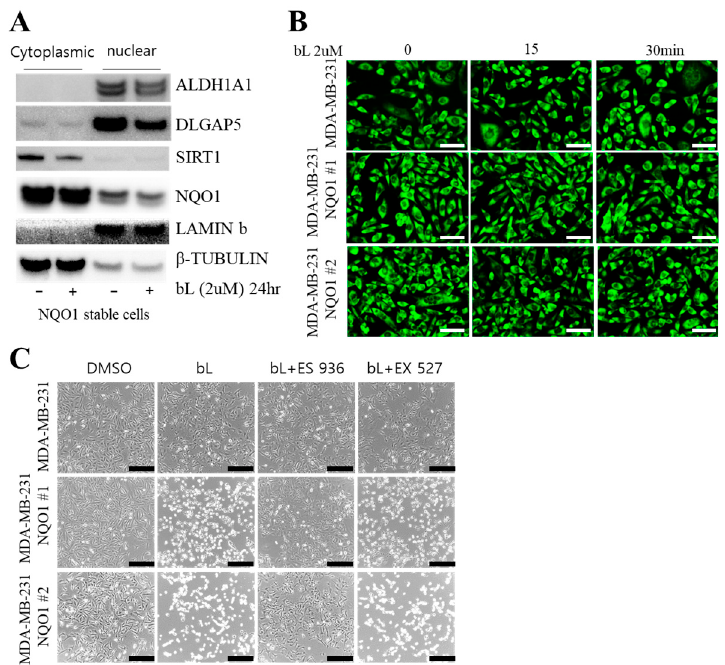
Figure 3. Sirtuin 1 (SIRT1) is not involved in bL-NQO1-mediated cell death. ( A ) Cytoplasmic and nuclear fractionation was performed as described in Section 4, using NQO1 stable cells with or without bL (2 µ M) for 24 h. The cell lysate was subjected to Western blot analysis with the indicated antibodies; β -tubulin and lamin B were used for cytoplasmic and nuclear markers, respectively. ( B ) Cellular localization of SIRT1 was examined in MDA-MB-231 and two independent clones of NQO1 stable cells (NQO1 #1 and #2) with or without bL (2 µ M) for the indicated time. Images were taken under a new hybrid microscope (Echo, San Diego, CA, USA). The scale bar is 130 µ m. ( C ) Cell morphologies of MDA-MB-231 and two independent clones of NQO1 stable cells (NQO1 #1 and #2) were examined after treatment with a combination of bL (2 µ M), an NQO1 inhibitor (ES 936, 1 µ M), and an SIRT1 inhibitor (EX 527, 1 µ M) for 24 h, as indicated. Images were taken using a new hybrid microscope (Echo, Echo, San Diego, CA, USA). The scale bar is 230 µ m